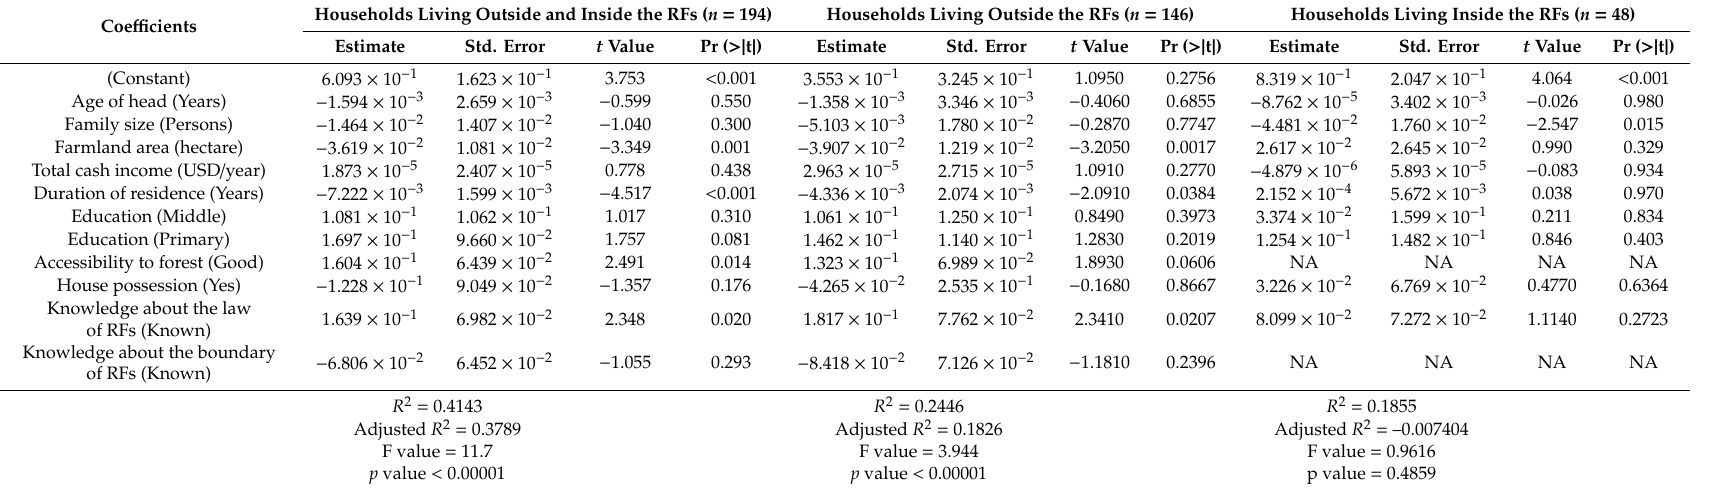
Table 4. Parameter estimates of the linear regression models explaining forest cash income dependency